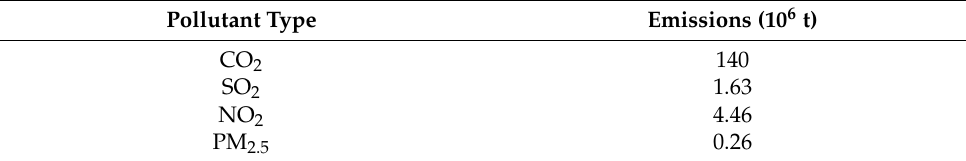
Table 1. Emissions by pollutant (t) of vessels calling at EU ports (2018–2019)